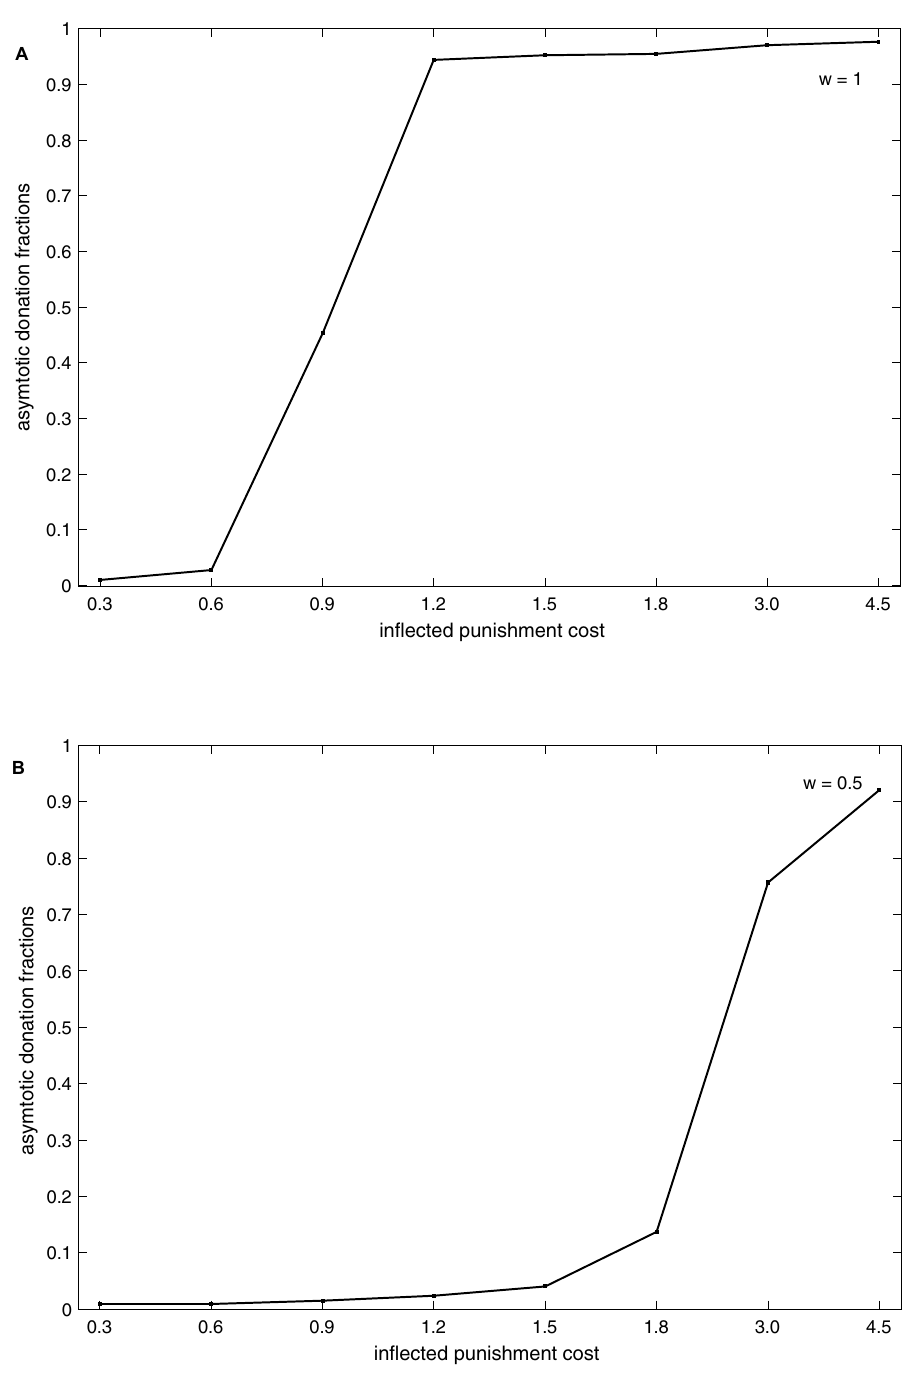
Figure 2. Asymptotic donations, fractions of population with various punishment costs. ( A ) ( w ) = 1 and ( B ) ( w ) =